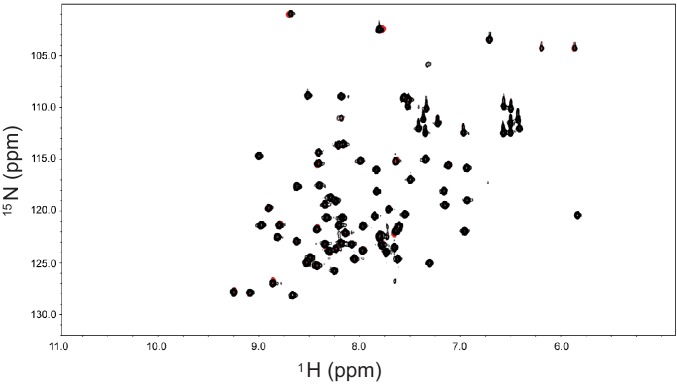
The N-terminal propeller of β'-COP (1-304) does not bind significantly to monoUb.HSQC spectra of 125 µM 15N-labeled ubiquitin in 40 mM NaPO4 (pH = 7.1) in the absence and presence of 1.25 mM unlabeled N-terminal propeller of β’COP. Spectra show an almost complete overlay of 15N Ub alone (red) and in the presence of a 10-fold excess of the N-terminal propeller of β'-COP (black).